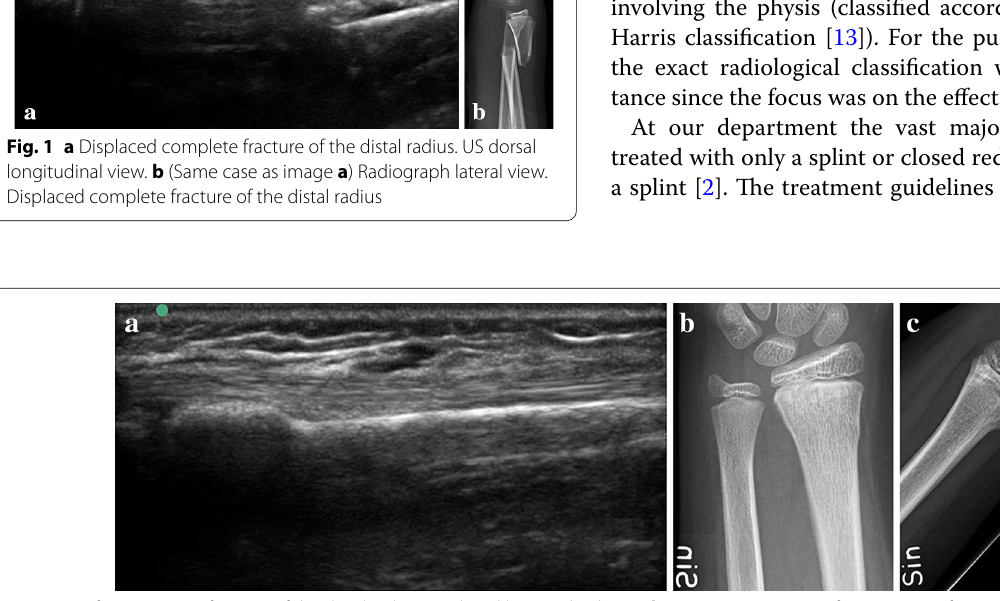
Fig. 2 a Infraction/torus fracture of the distal radius, US dorsal longitudinal view. b , c (Same case as a ) Infraction/torus fracture of the distal radius on lateral and AP